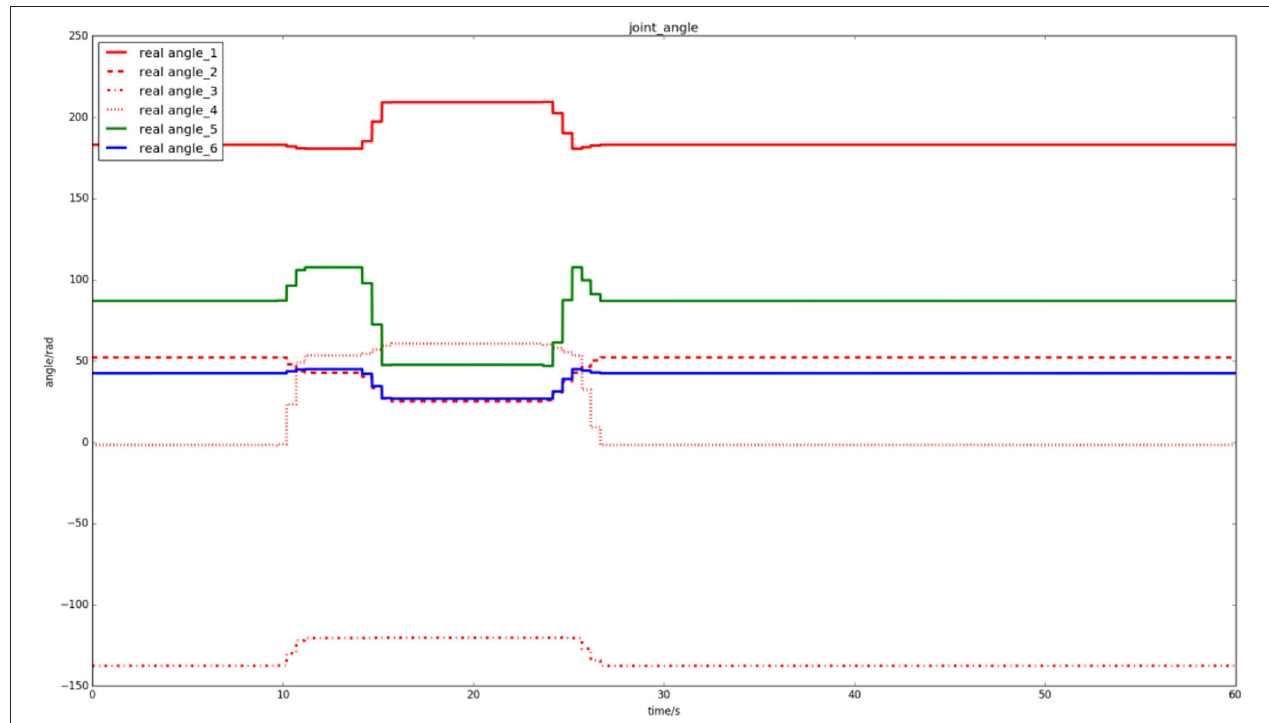
FIGURE 18 | Joint trajectories of the robot in cooperative assembly task.